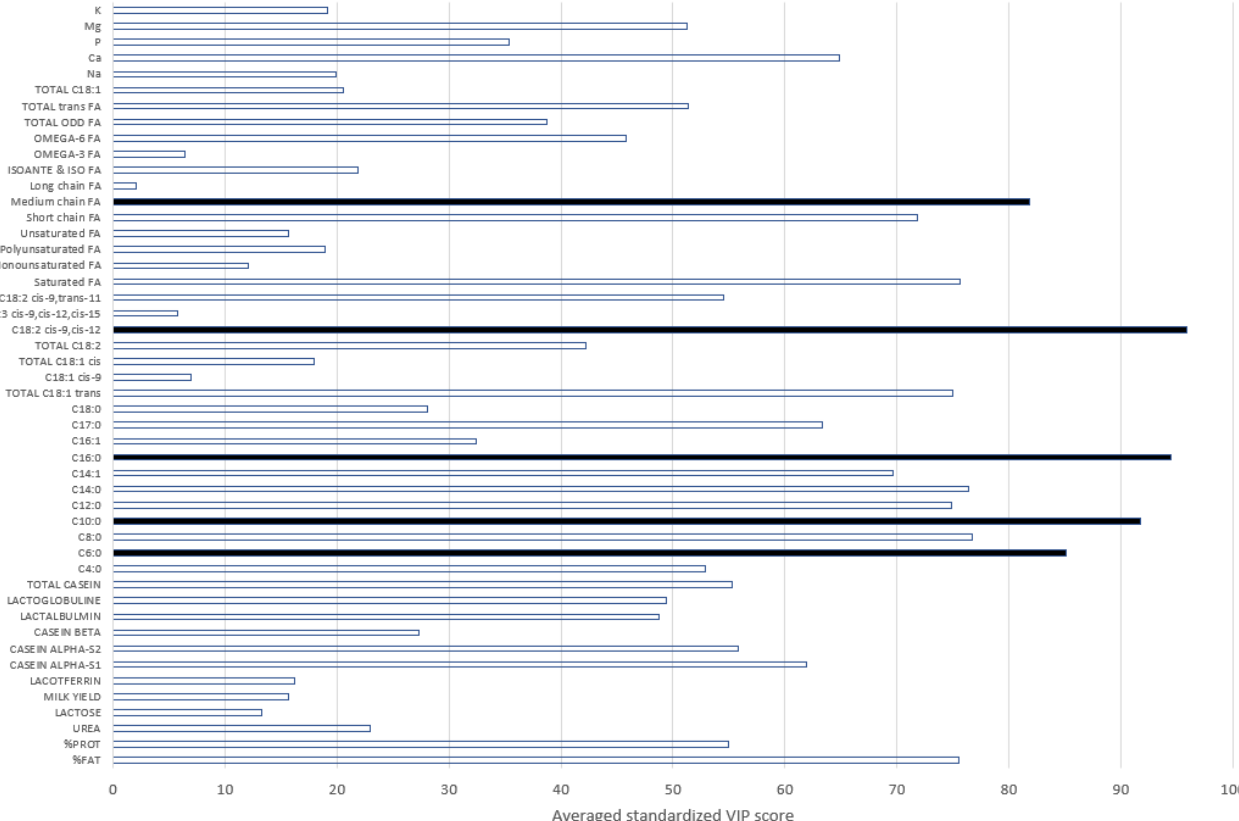
Figure 4. Scores of the Variable Importance in Projection (VIP) for all predictors and models. Black bars represent the most important traits (FA = fatty acids).